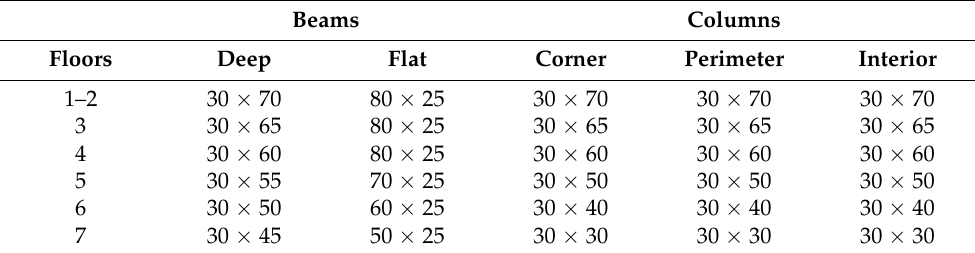
Table 4. Cross sections of beams and columns of the B7 structure (dimensions in cm). Beams Columns